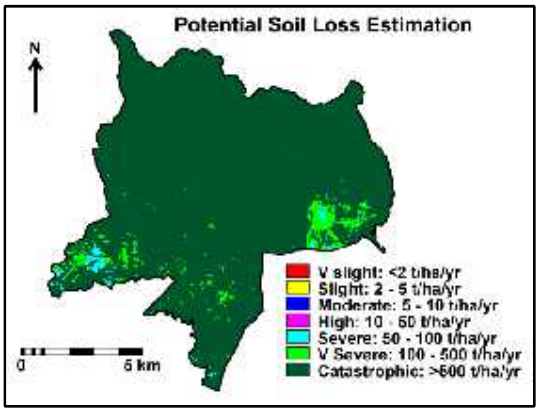
Figure 5. Potential soil loss estimation